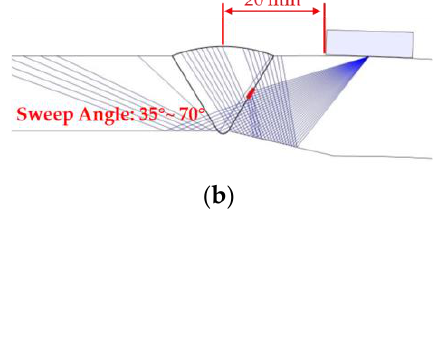
Figure 7. Scan plan drawing for simulation; ( a ) index offset 8 mm, sweep angle 35 – 75 ° assigned for the flange – elbow structure; ( b ) index offset 20 mm, sweep angle 35 – 70 ° assigned for tapered elbow structure; ( c ) index offset 62 mm, sweep angle 35 – 70 ° assigned for tapered upper